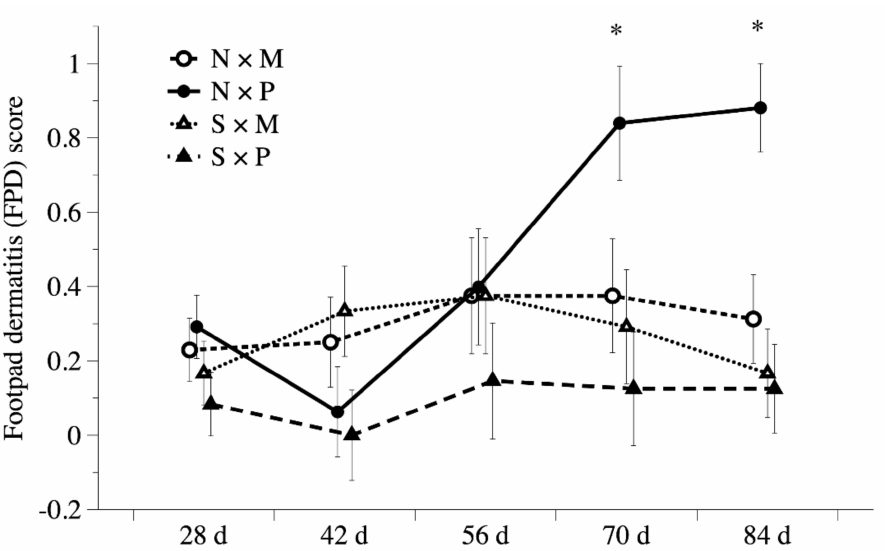
Figure 4. Comparisons of FPD score in White Roman geese subjected to different floor types and pool conditions at different days of age. N × M: no swimming pool on the mud floor. N × P: no swimming pool on perforated plastic floor. S × M: swimming pool on the mud floor. S × P: swimming pool on perforated plastic floor. * p <